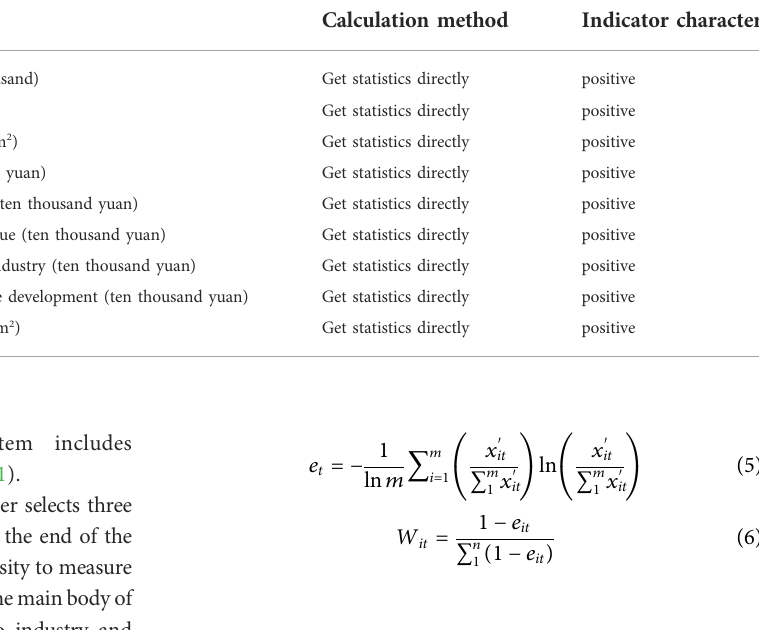
TABLE 1 Population-industry-housing coupling coordination degree evaluation index